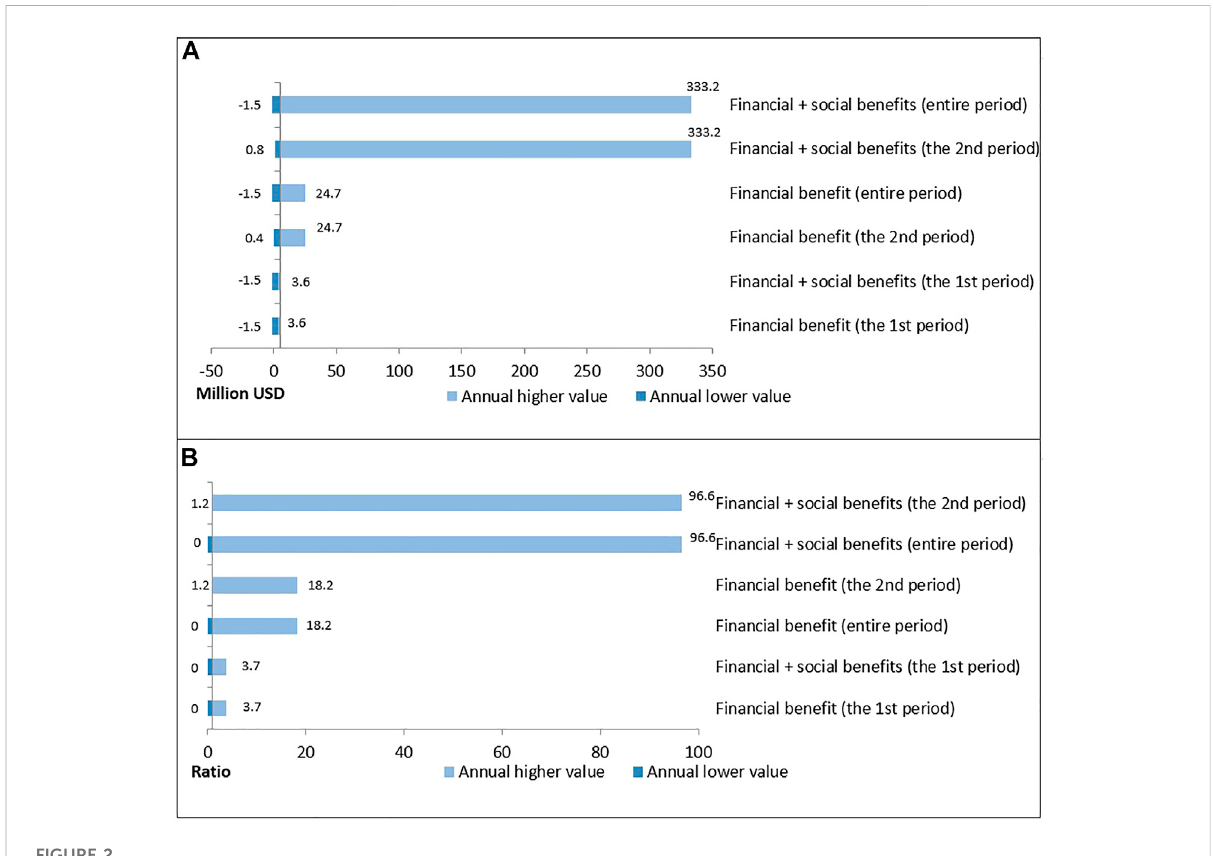
FIGURE 2 A tornado diagram of the sensitivity